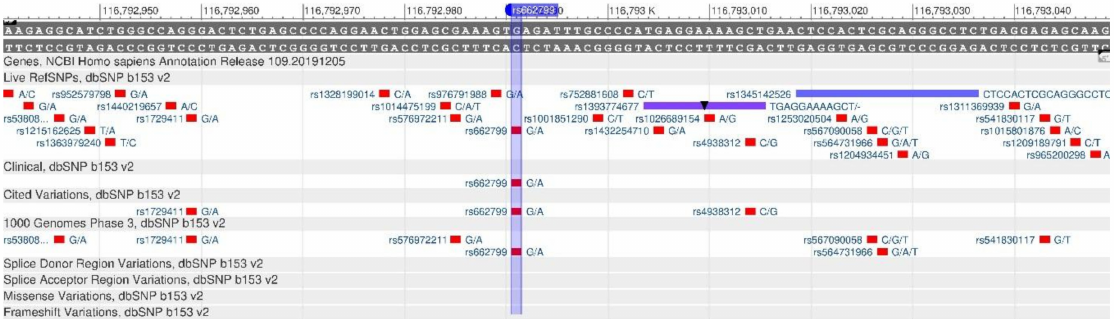
Figure 9. ApoA5 gene region (located on the long (q) arm of chromosome 11) containing the oligonucleotide polymorphism